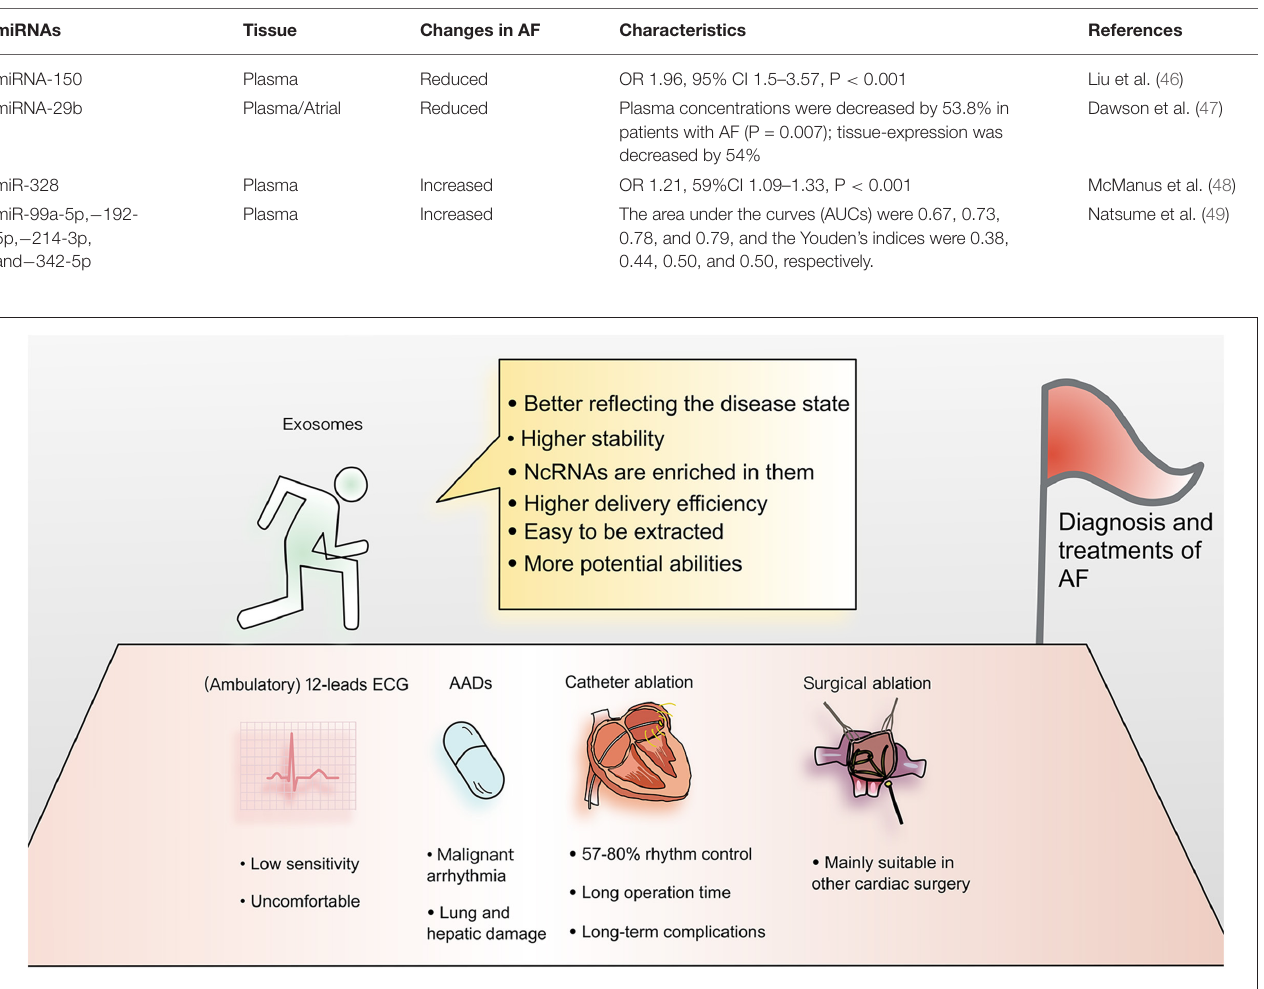
FIGURE 2 | Advantages of applying exosomes to the diagnosis and treatment of atrial fibrillation. Current diagnosis and treatment methods for AF have many limitations. Exosomes have become a focus of cardiovascular research. Due to their many advantages, exosomes are thought to have the potential to overcome current limitations and provide new methods for understanding the mechanism and improving the diagnosis and treatment of